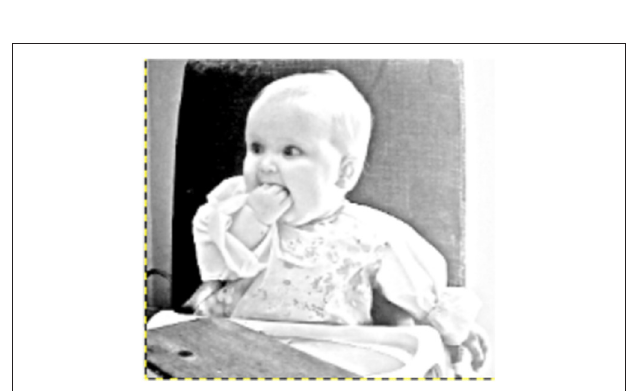
FIGURE 5 | Image published with the written informed consent of the parents of the depicted